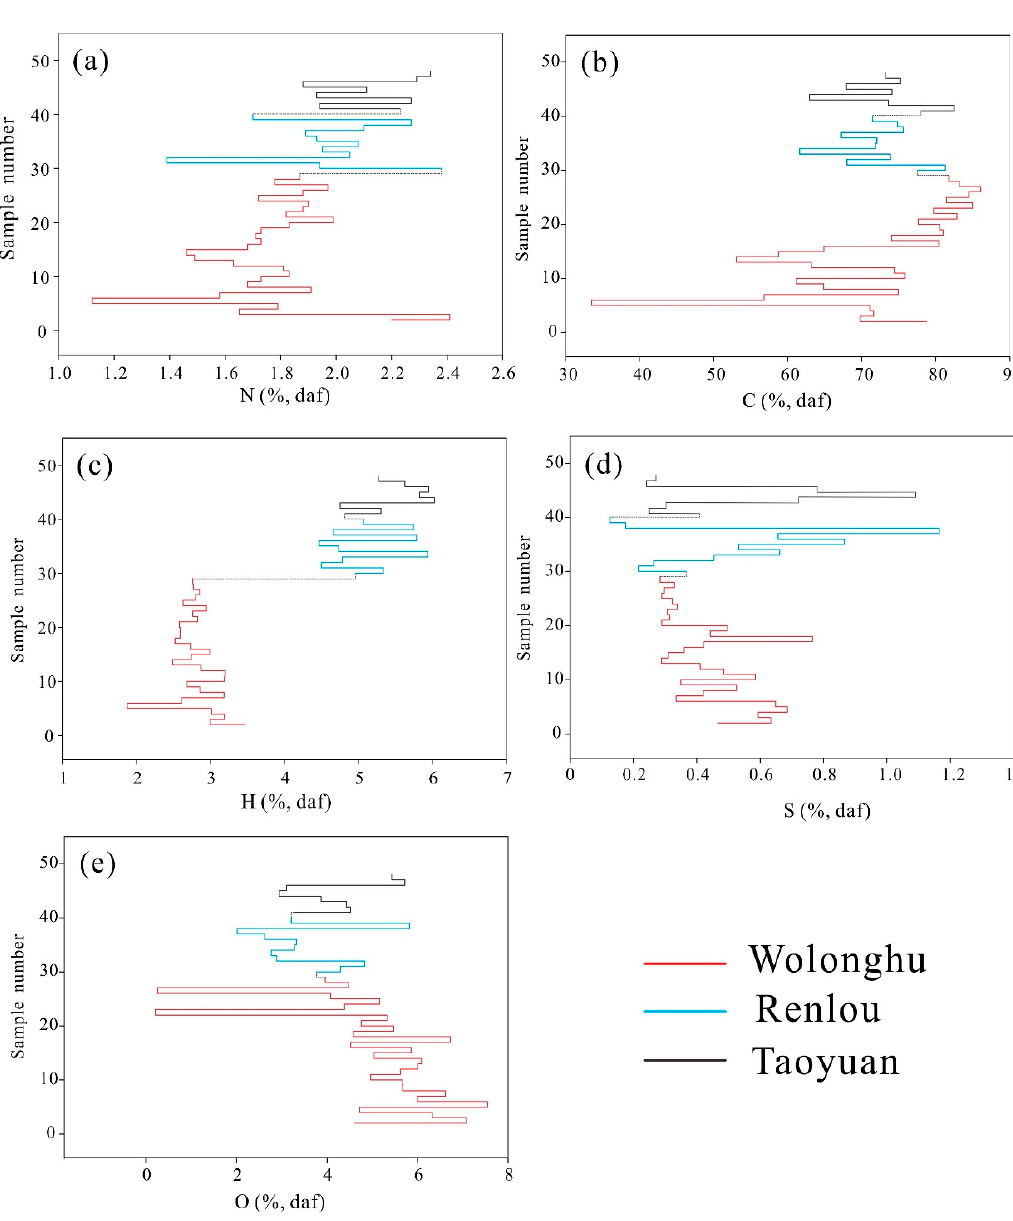
Figure 4. Element distributions of N ( a ), C ( b ), H ( c ), S ( d ), and O ( e ) in the selected coals from the Huaibei Coalfield.